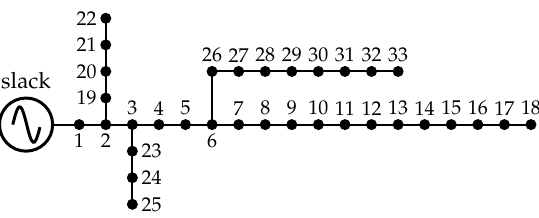
Figure 2. Electrical configuration of the 33-node test system.